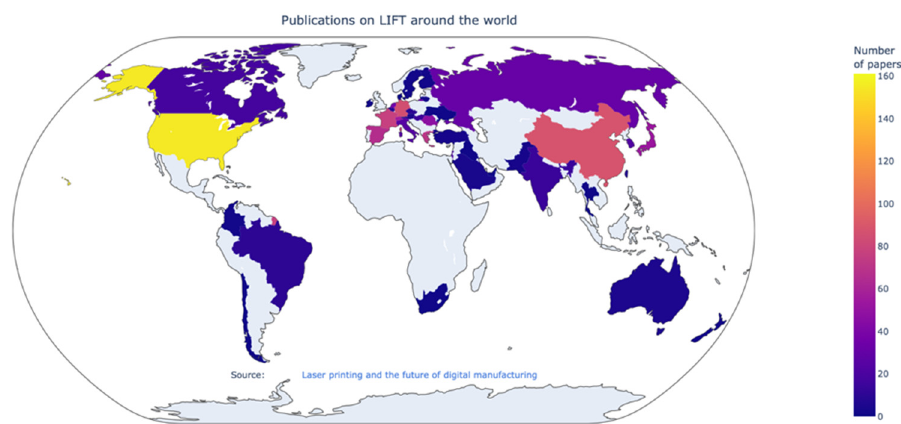
Figure 6. Geographical distribution of the total amount of publications per country on LIFT around the world. Data obtained via the ISI Web of Science by sorting the keyword “laser induced forward transfer” as of 8 June 2022. An interactive resource is available as a Supplementary Material. Table 2 contains a list with the names of the main funding agencies that made possi- ble most of the contributions of the researchers on the field in these countries, including the number of papers produced and its percentage with respect to the total number of publications (661). This information is also available at the ISI Web of Science database. Table 2. Main international funding agencies that support the research reflected in the published papers on LIFT, according to the ISI Web of Science, by sorting the keyword “laser induced forward transfer” as of 11 November 2022.